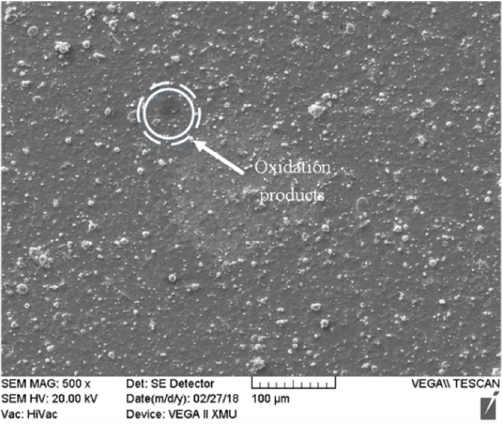
Figure 18. SEM image of TiN/ZrN coating after hot corrosion for 4 h.